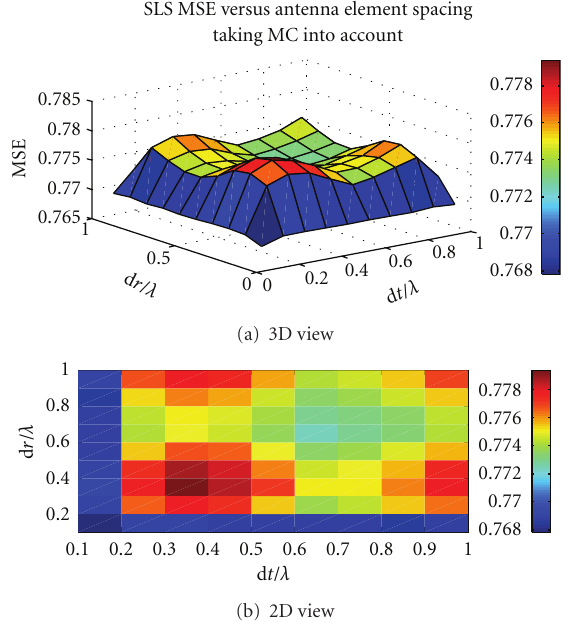
Figure 5: SLS MSE versus transmitter and receiver antenna element spacing taking MC into account.